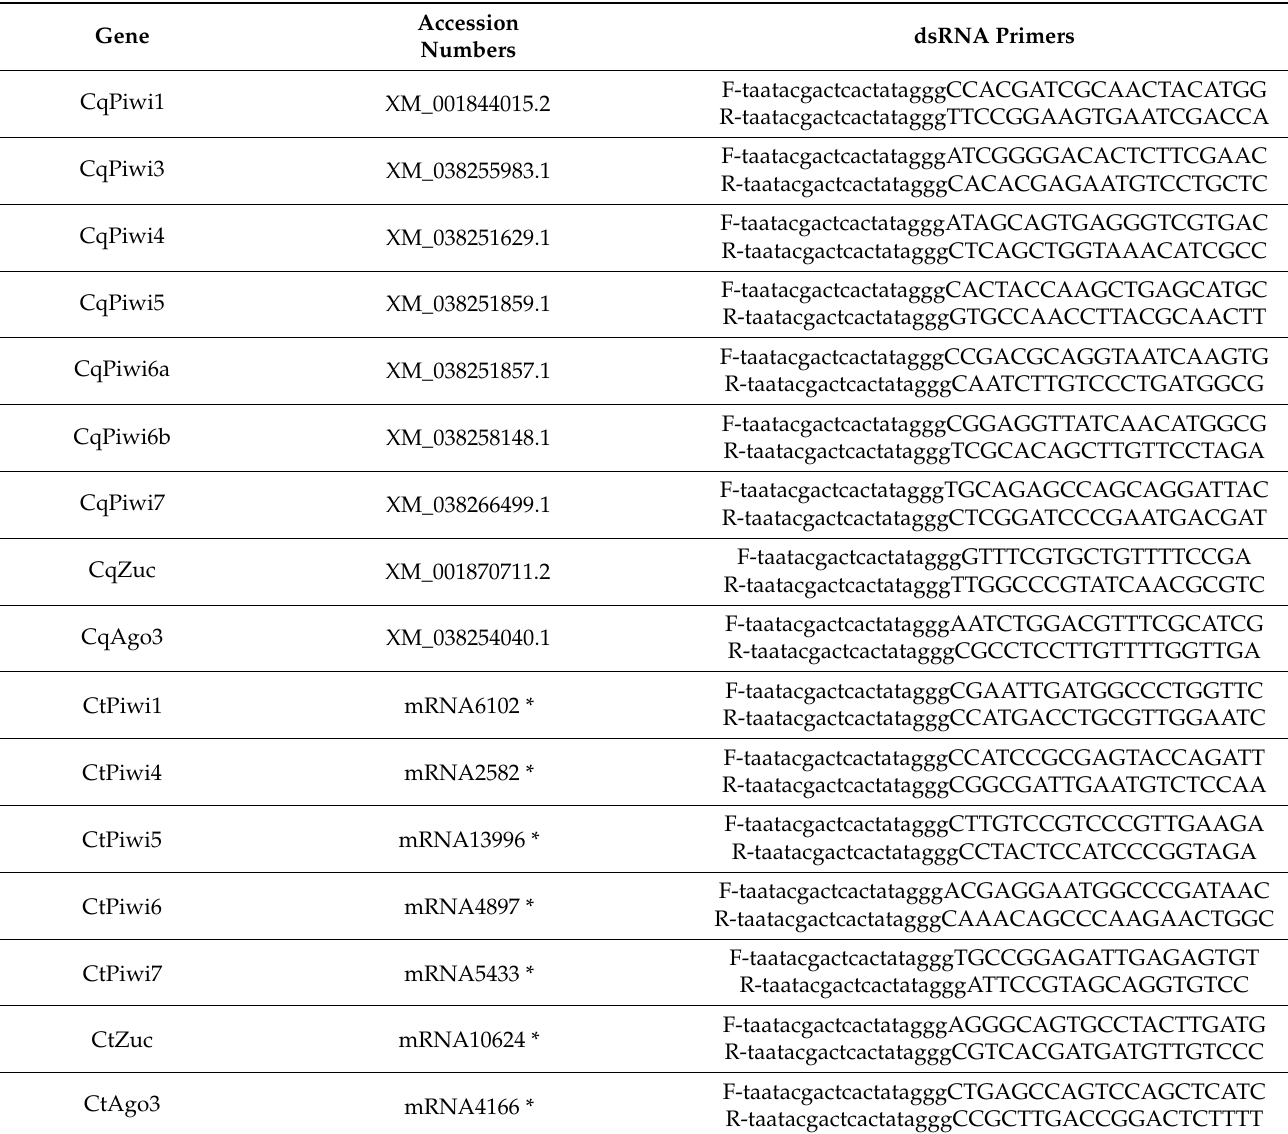
Table 1. Cx. quinquefasciatus (Cq) and Cx. tarsalis (Ct) primers used to generate